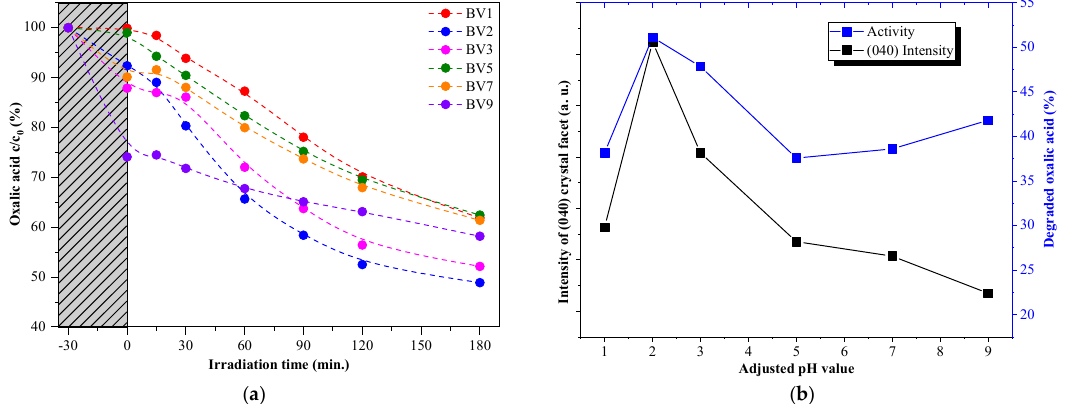
Figure 4. The photocatalytic activity of the samples in the degradation of oxalic acid under visible light irradiation ( a ). The activity trend similarity with the (040) crystallographic plane’s dominance trend ( b ). Please note that the lines used to connect the data points are only there to increase the readability of the figure and do not represent any mathematical trends or equation fittings. Molecules 2020 , 25 , x FOR PEER REVIEW